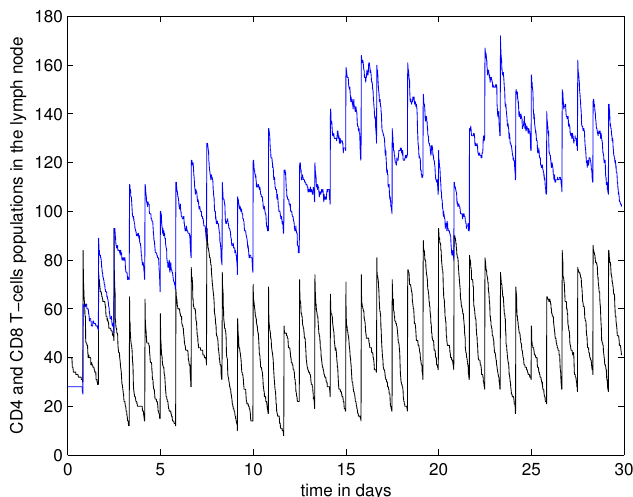
Figure 6. The dynamics of populations of naive and mature HIV-specific CD4 + (black curve) and CD8 + (blue curve) T cells in the lymph node.